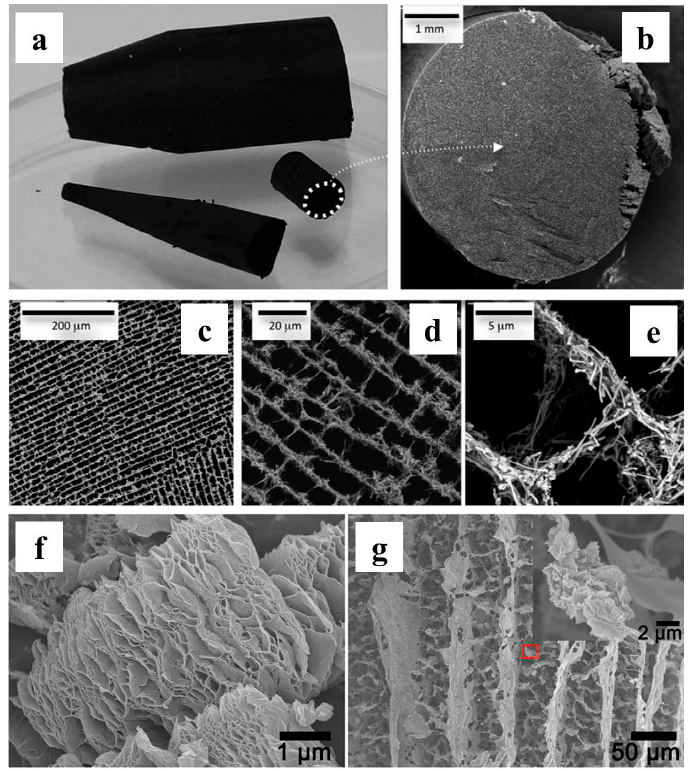
Figure 7. ( a , b ) Photograph and ( c – e ) SEM images of chitosan/MWCNT 3D scaffold prepared by with ice template [99]; ( f , g ) SEM images of chitosan/vacuum stripped graphene scaffold [100]. Reproduced with permission from the Royal Society of Chemistry, Elsevier and American Chemical Society.